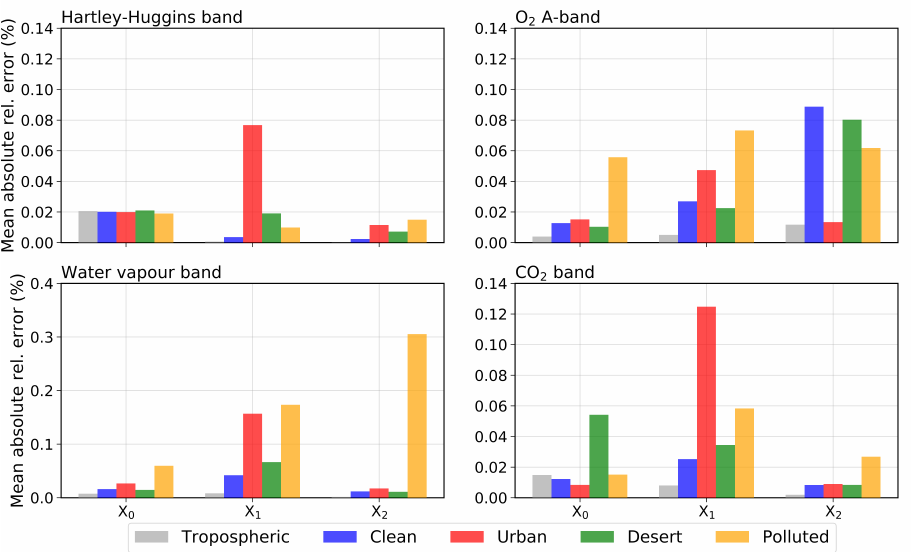
Figure 6. Mean absolute relative error in % for the four spectral bands, as well as for all aerosol types. Each bar colour corresponds to an aerosol type, while each group of bars corresponds to one of the X i -matrix ( i = 0,1,2) (Equations (8)–(10)) used in the CLSR method. Note that the scale of the water vapour band is different from the rest of the spectral